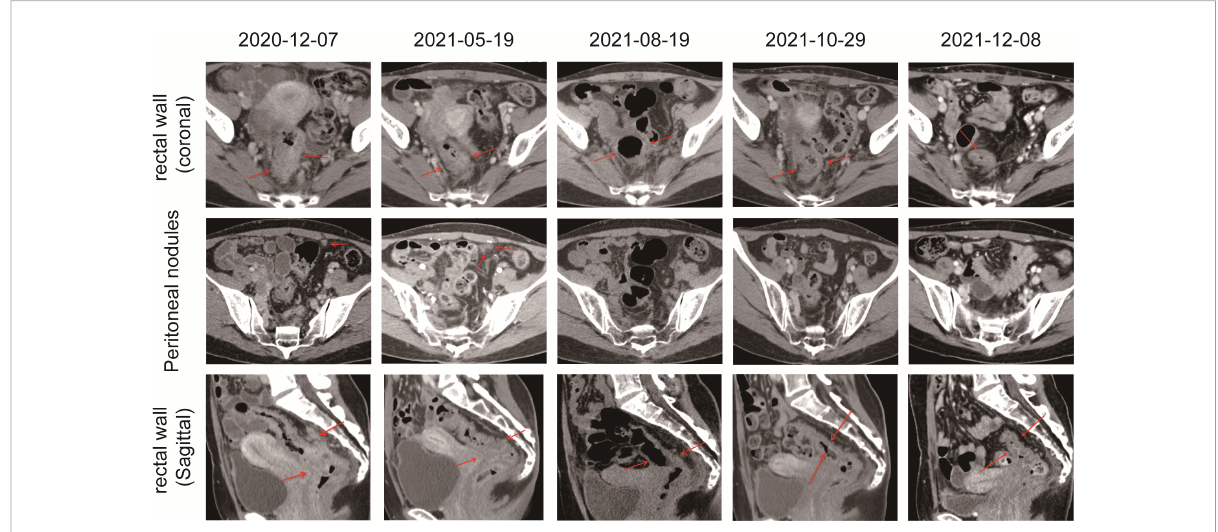
FIGURE 2 CT scans showed the chronological response of the patient following a series of treatment. The red arrow represents the area of the target